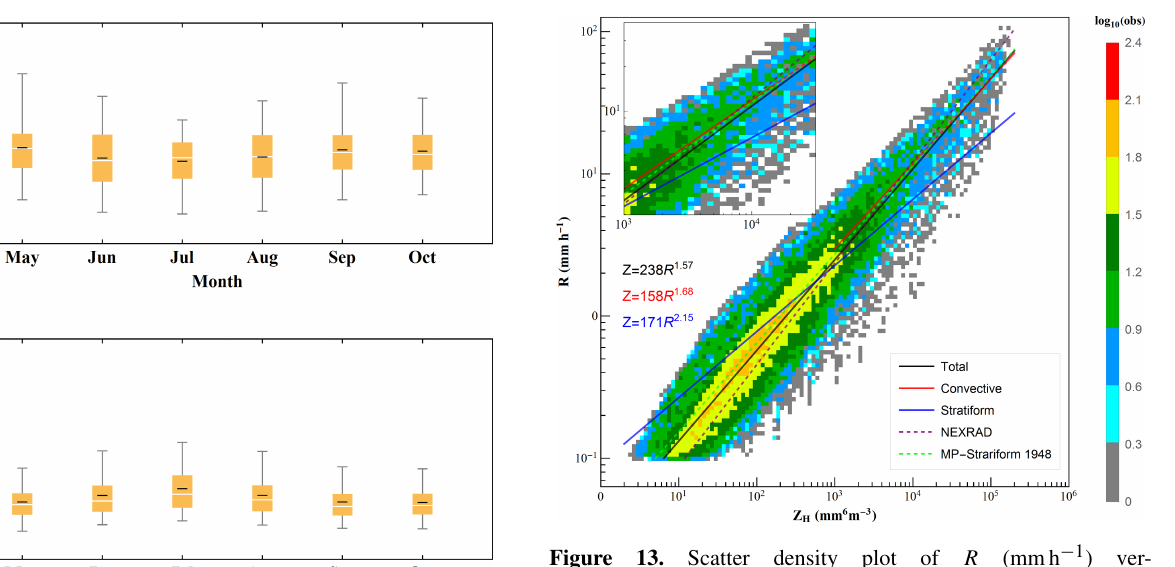
Figure 13. Scatter density plot of R (mmh − 1 ) ver- sus Z H (mm 6 m − 3 ) for all rain events. The black, red, and blue curves, respectively, stand for the fitted power-law relations for total rain, convective rain, and stratiform rain. The purple and green dashed lines denote the default NEXRAD Z – R relation (Fulton et al., 1998) and a commonly used continental stratiform rain relation (Marshall and Palmer, 1948),